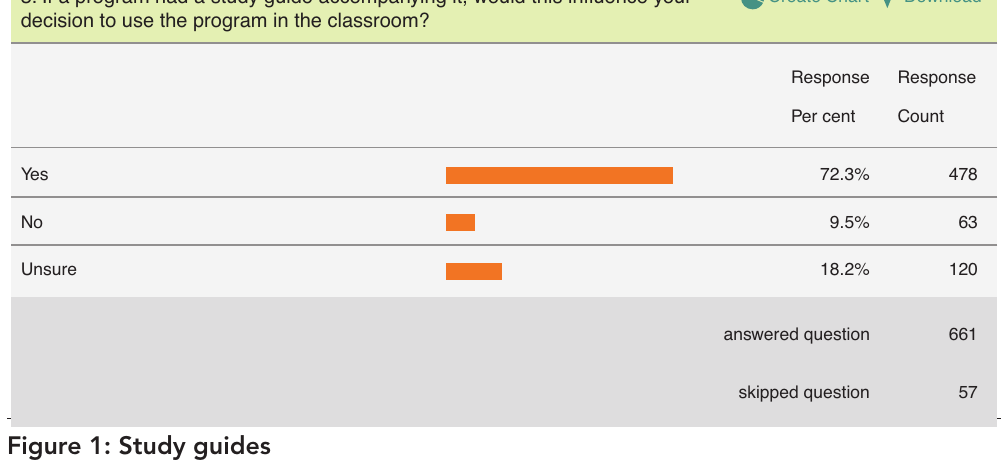
figure 1: Study guides Source: Adapted from Screenrights